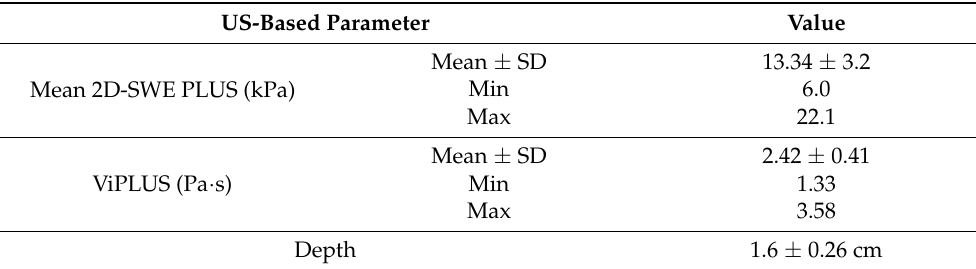
Table 2. US-based two-dimensional SWE and viscosity measurements of thyroid tissue in healthy subjects.